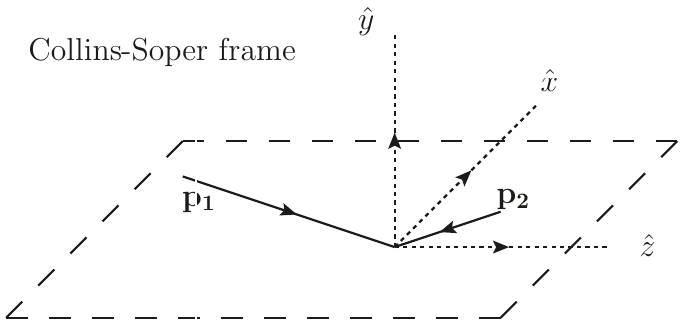
Figure 1 . Sketch of the Collins-Soper frame. p 1 ; p 2 correspond to the three momenta of the right- and left- (cid:13)ying